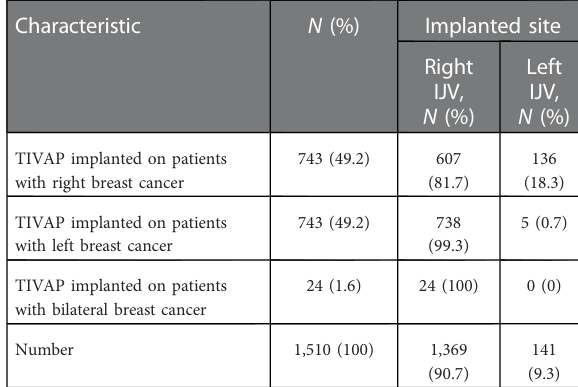
TABLE 2 Details of TIVAP implantation ( N =1510).